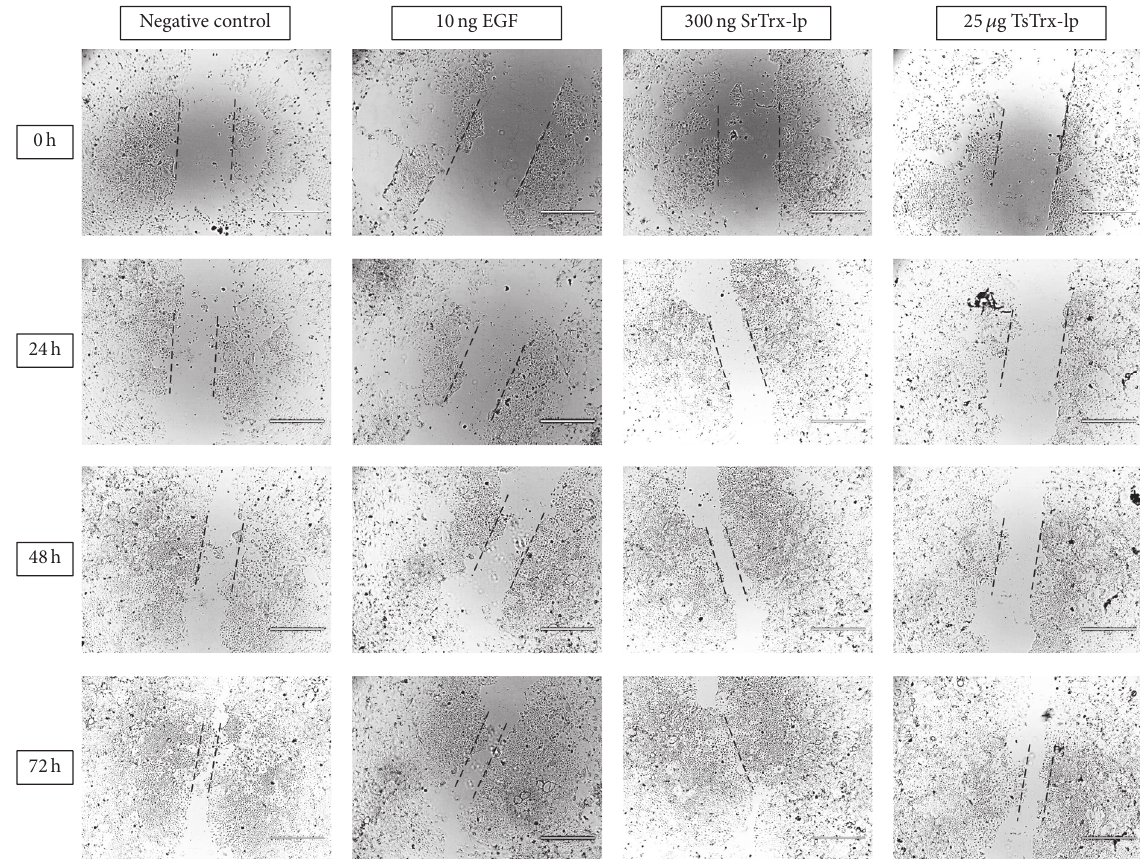
Figure 9: Wound healing assay with Caco-2 cells and the S. ratti as well as the T. suis Trx-lp. The CytoSelect (cid:3) 24-Well Wound healing assay was performed. Here, two examples are described as representatives for different tested concentrations. Protein concentrations of 300 ng SrTrx-lp are given as example for best concentration for wound healing promotion and 25 𝜇 g of TsTrx-lp (each per 500 𝜇 L) indicated the less wound healing-promoting concentration. The wound healing process of a 0.9 mm wound field generated was observed over 96 h, whereby each 24 h a picture was taken. The size of the scale bar is 1000 𝜇 m and the dashed black lines indicate wound-like area